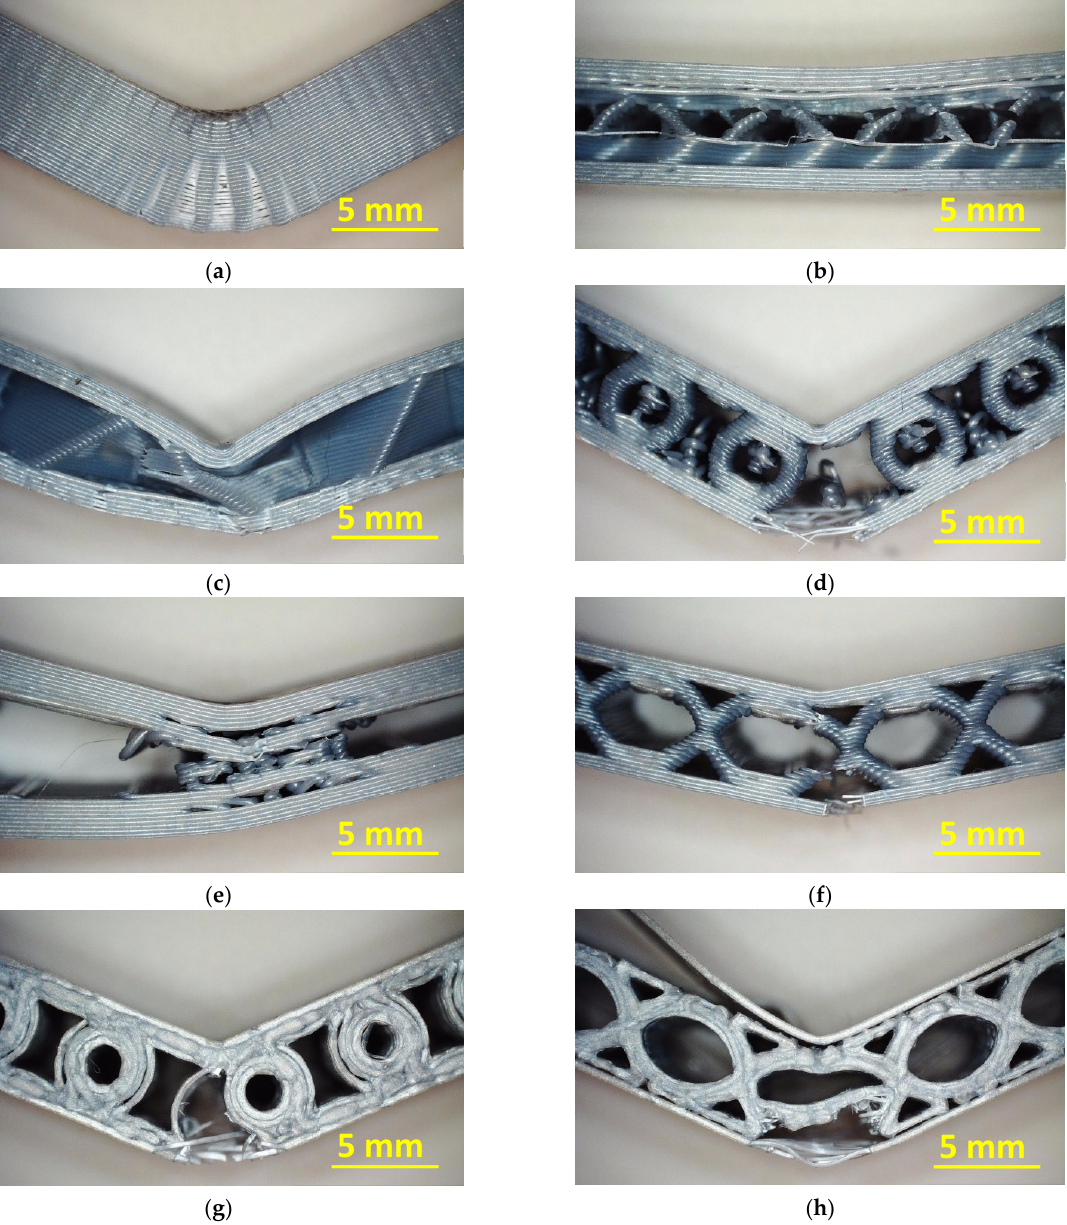
Figure 2. Microscopic images taken after three-point bending tests of samples with different infill patterns: ( a ) LN100; ( b ) GY15; ( c ) OC15; ( d ) ZHR100; ( e ) LP100; ( f ) EW100; ( g ) ZHR100 printed on the long edge; and ( h ) EW100 printed on the long edge. Sample LP100, printed on the long edge, will be shown later.